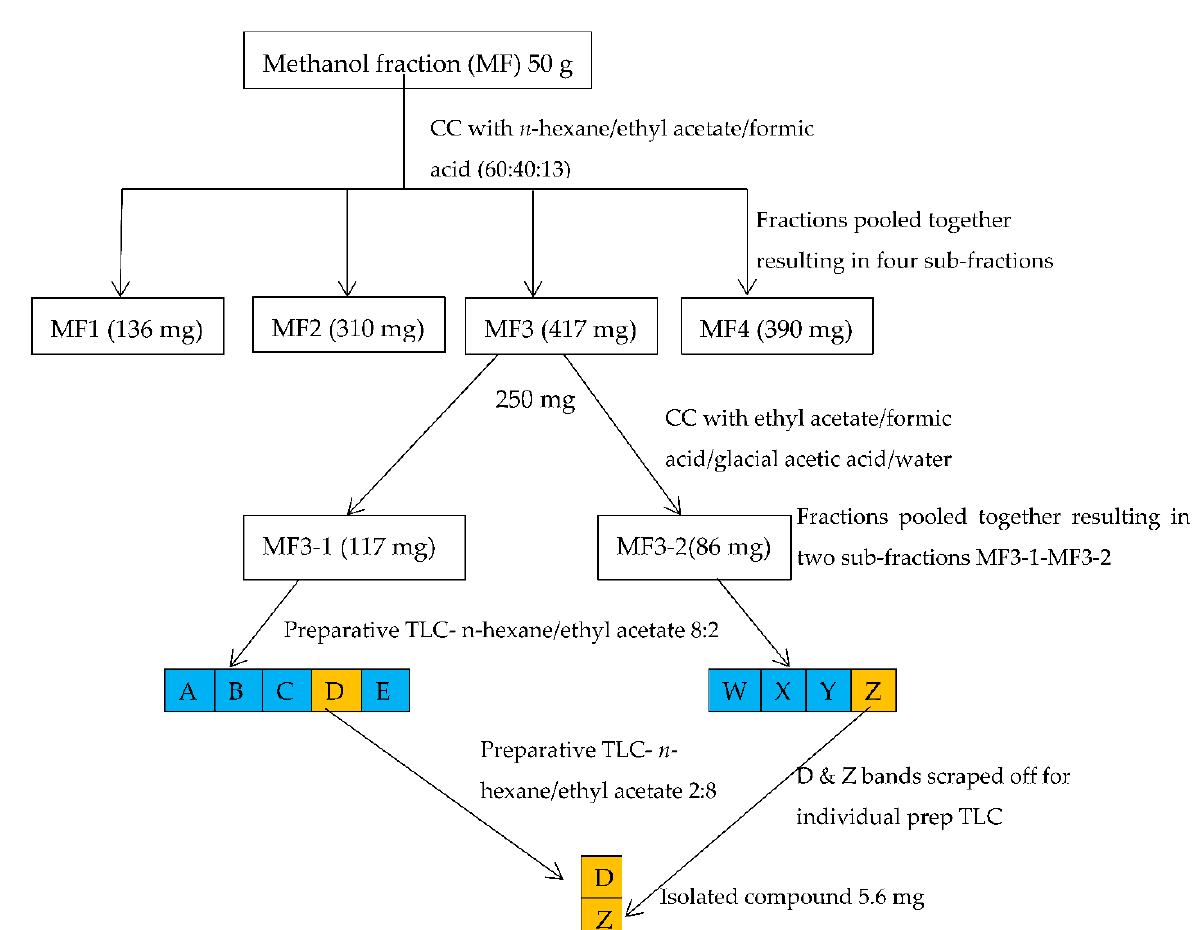
Figure 8. Schematic diagram of bioassay guided isolation of compound.